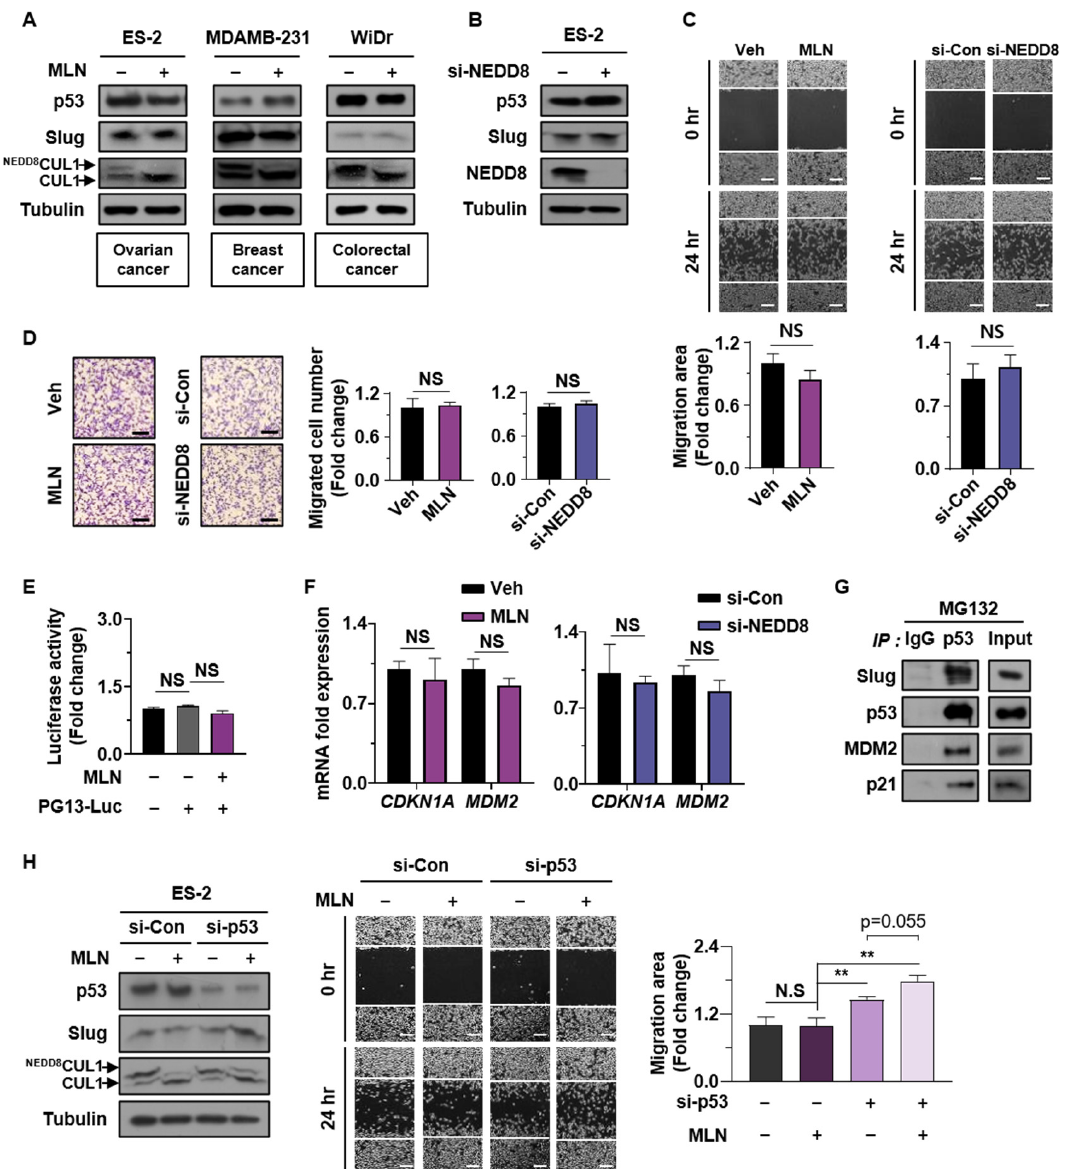
Figure 5. Interaction of mutant p53 with Slug neutralizes the effect of neddylation on cell migration. ( A , B ) ES-2, MDAMB- 231, and WiDr cells treated with vehicle or MLN4924, and ES-2 cells transfected with si-Control or si-NEDD8 were subjected to Western blot assays. ( C , D ) ES-2 cells were subjected to wound healing and Transwell assays with or without MLN4924 or transfected with si-Control or si-NEDD8. Scale bar: 200 µ m. Whole areas were measured using ImageJ software. The numbers of cells in four randomly chosen fields were counted. Data are presented as the means ± standard deviation ( n = 3). ( E ) ES-2 cells were co-transfected with luciferase plasmid and the other plasmid shown and then subjected to luciferase reporter assays. The results were normalized to β -galactosidase activity. Data are expressed as means ± standard deviation ( n = 3). ( F ) ES-2 cells were treated with or without MLN4924 for 16 h and subjected to RT-qPCR to analyze mRNA levels of MDM2 and p21. Data are expressed as means ± standard deviation ( n = 3). ( G ) ES-2 cells treated with MG132 for 6 h, and the cell lysates were assessed by immunoprecipitation using an anti-p53 antibody. Precipitated proteins were analyzed by Western blot assays. ( H ) ES-2 cells transfected with si-Control or si-p53 and treated with or without MLN4924 were subjected to wound healing assay and western blot. Scale bar: 200 μ m. Whole areas were meas- ured using ImageJ software. The numbers of cells in four randomly chosen fields were counted. Data are presented as the means ± standard deviation ( n = 3). ** p < 0.01; NS, not significant.